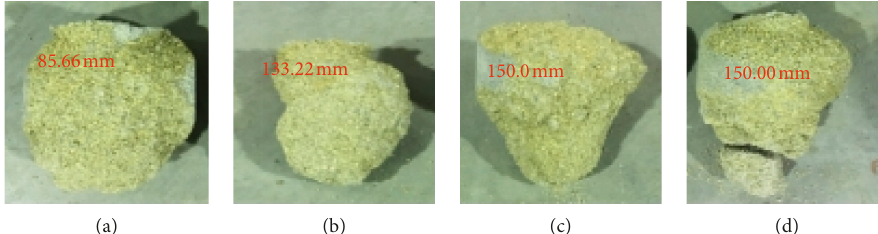
Figure 4: Shape of concretion of sample after grouting with different water-cement ratios of soil sample S2. (a) W / C � 0.5. (b) W / C � 0.6. (c) W / C � 0.8. (d) W / C � 1.0.